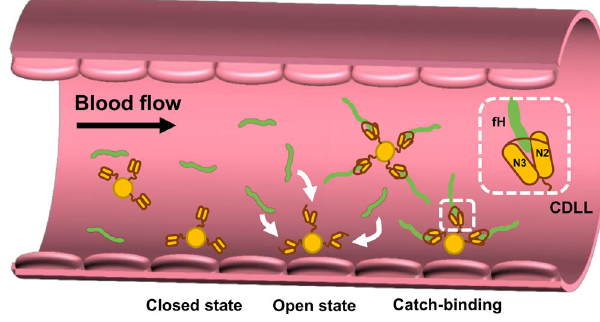
Fig. 6 Molecular model of the stress-activated capture of fH by